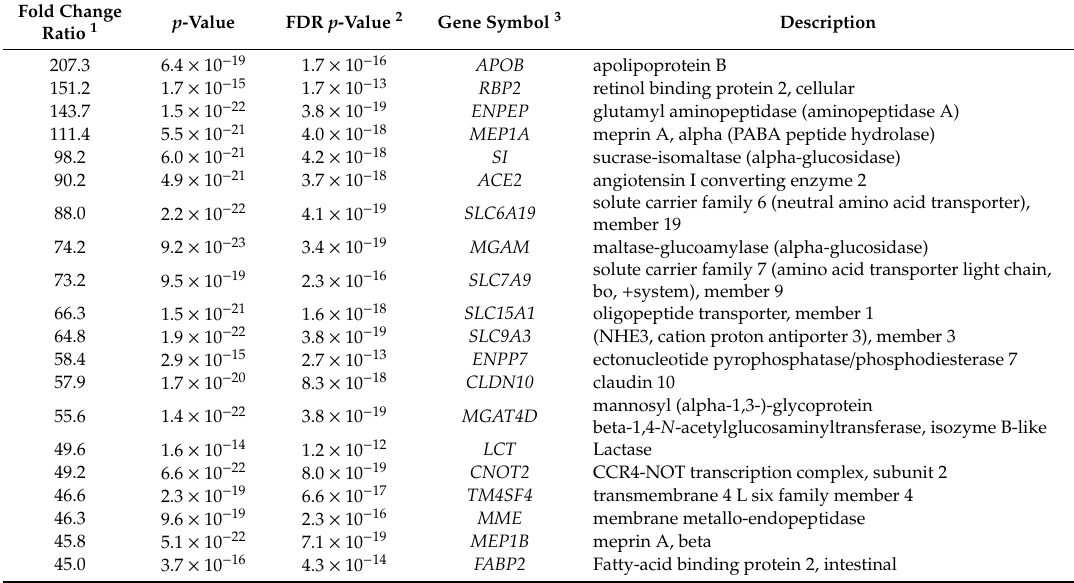
Table 1. List of the first 20 di ff erentially expressed transcripts (DETs) in the jejunal mucosa of broiler chickens ranked by fold change ratio (FCR), compared to the cecal mucosa.